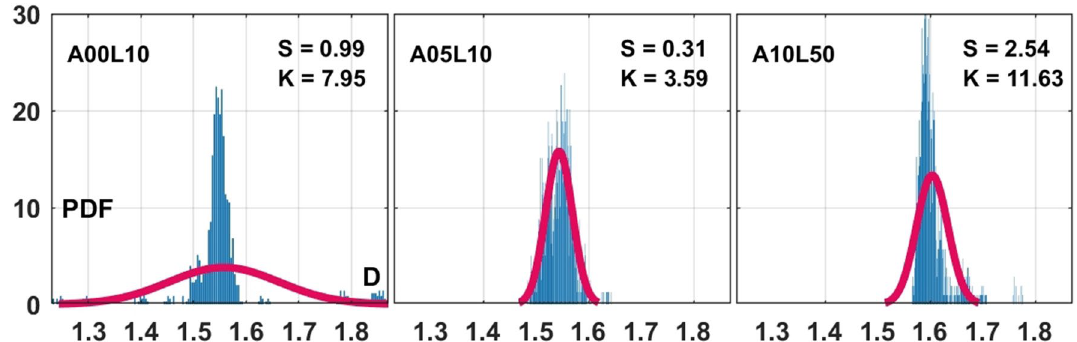
Figure 5. Discrete (blue bars) probability density function (PDF) of the fractal dimension D for the A 00 L 10, A 05 L 10 and A 10 L 50 cases at bio-oil preheating temperature of T = 24 ( ◦ C) ( T 24 cases) compared to the Gaussian normal distribution (red line), where S and K respectively denote skewness and